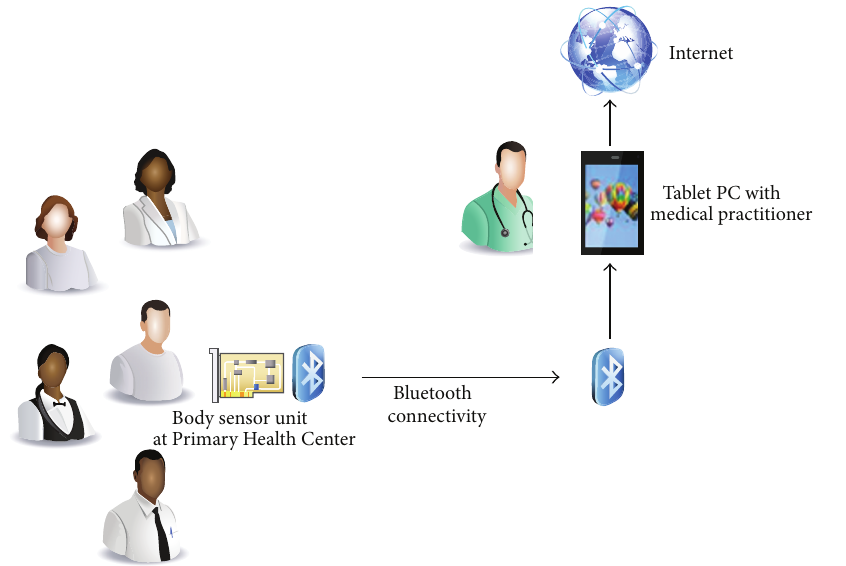
Figure 2: Proposed telehealth system architecture with remote monitoring